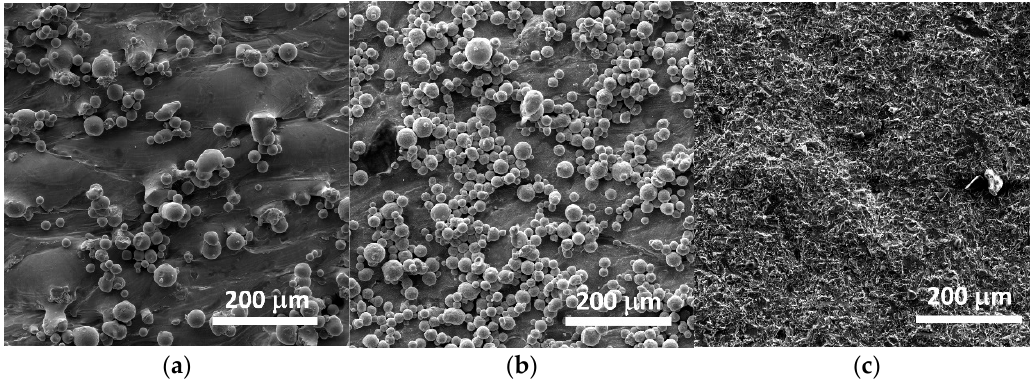
( b ) Figure 7. Surface profile of ( a ) Sample 5 and ( b ) Sample 6. 3.3. Mössbauer Spectroscopy Transmission Mössbauer spectra (Figure 8) of the initial powders were fitted in ac- cordance with the fact that the metals crystallize dominantly into BCC (body-centered cubic) and FCC (face-centered cubic) crystal structures. The shape of the Mössbauer spec- trum of austenitic stainless steel (1.4404) is determined by substitutional and interstitial atoms in the paramagnetic γ -Fe crystal. The single peak is characteristic for the γ -Fe (FCC structure) Mössbauer spectrum, but substitutional and interstitial atoms (dominantly Cr and Ni) in austenitic stainless steel cause a broadening of the spectrum; therefore, the Mössbauer spectrum is fitted with a doublet with small quadrupole splitting [40]. The sextet (magnetic hyperfine split) with a 33 T hyperfine magnetic field is characteristic for the Mössbauer spectrum of α -Fe (BCC structure), but substitution atoms in ferritic steel are the cause of the distribution of hyperfine magnetic fields [41]. Thus, the experimental Mössbauer spectrum of the CL20ES powder was fitted with a doublet (austenitic phase) and the spectrum of the CL50WS powder was fitted with a doublet (austenitic phase) and a sextet (ferritic phase) with a distribution of the magnetic field (Figure 8, Table 2). The backscattering Mössbauer spectra (CEMS and CXMS) of all samples manufactured by